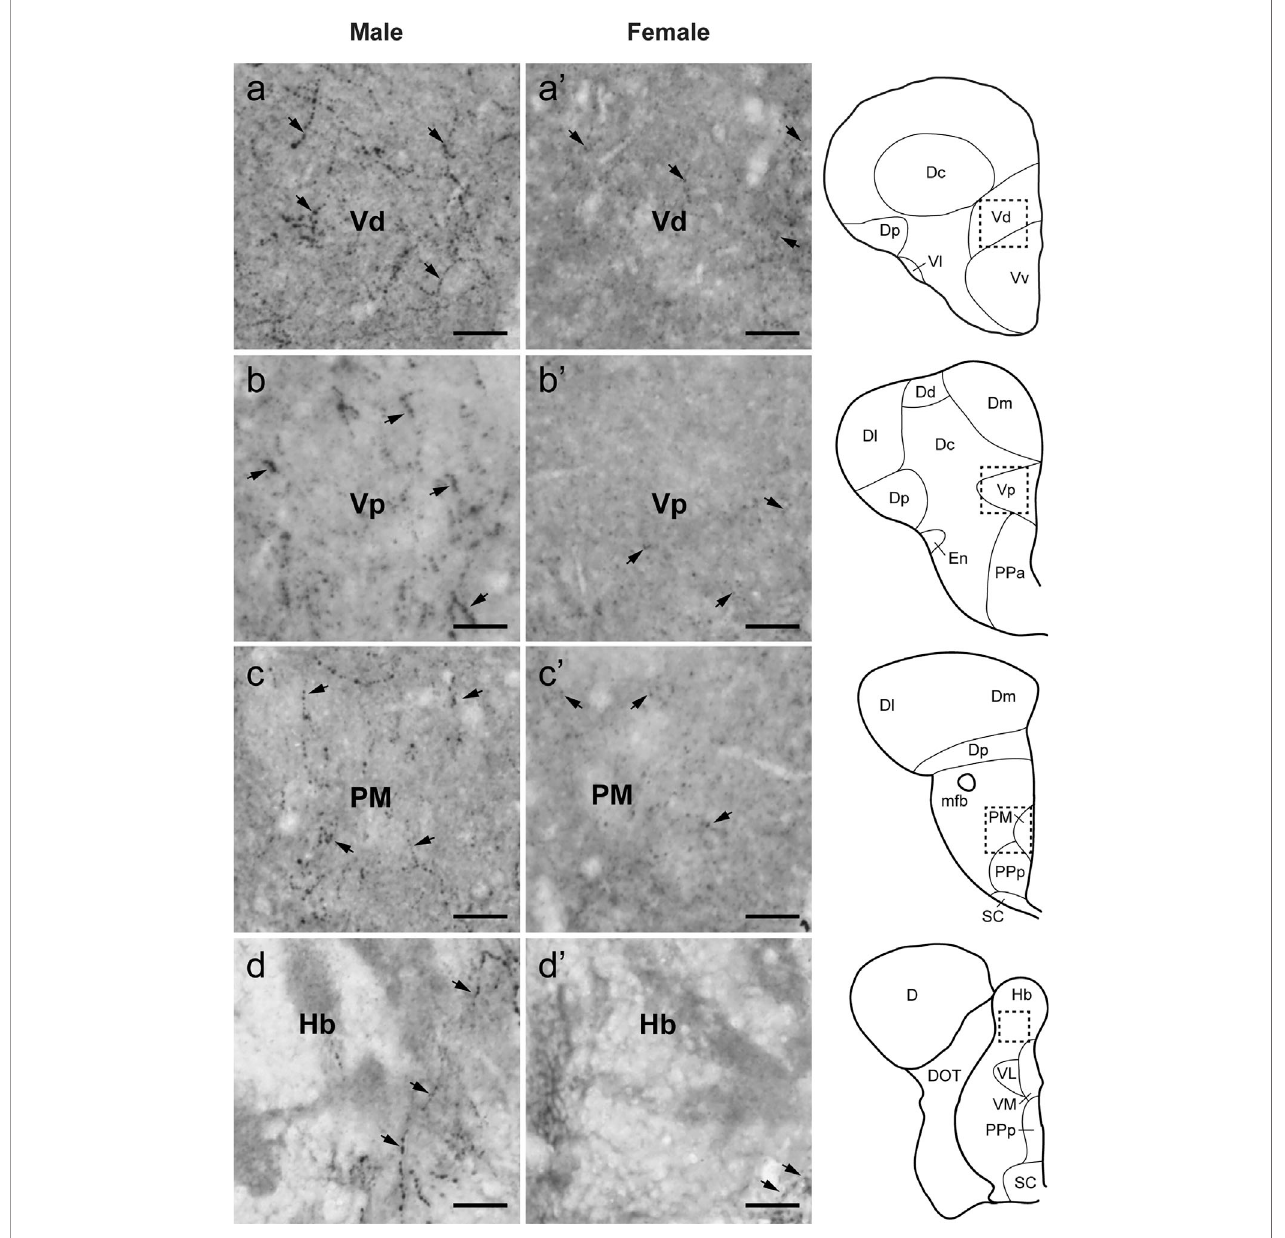
FIGURE 5 | Sexual dimorphisms in Tac1-immunoreactive processes in the telencephalic and diencephalic regions. Left (A − D) and middle (A ’ − D ’ ) columns represent photomicrographs of Tac1-immunoreactive processes (arrows) in the brain of males and females, respectively. Boxes with a dotted line in the schematic drawing of coronal view in the right column indicate the localization of the boundaries of the respective immunohistochemical illustrations. In the ventral part of the ventral telencephalon, more Tac1-immunoreactive processes are seen in male brains (A − C) as compared to females (A ’ − C ’ ) . Similarly, more Tac1-immunoreactive processes are observed in the habenula nuclei in males as compared to female (D , D ’ ) . Scale bars: 20 µm. See Glossary for